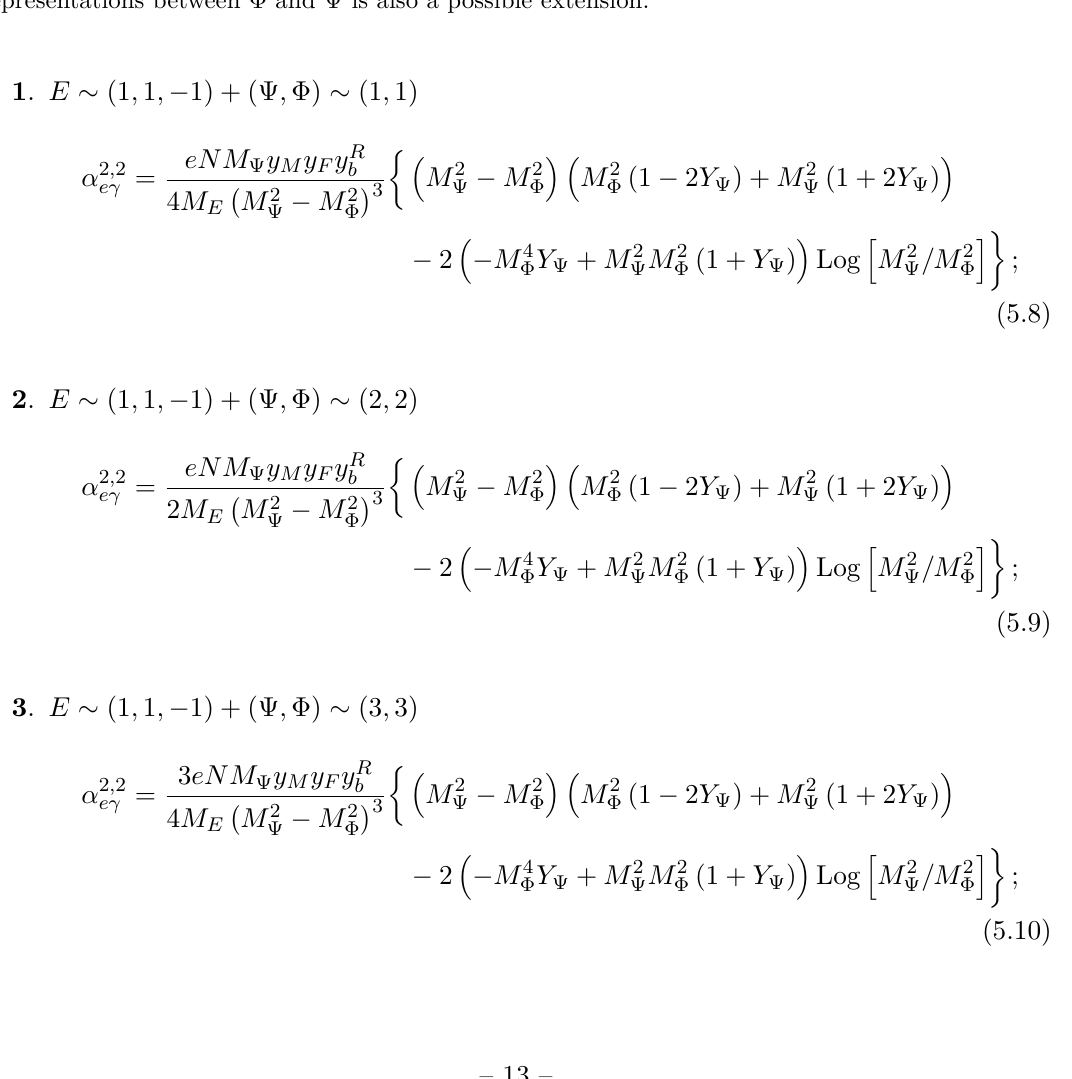
Table 3 . Three-field UV extensions which generate the bridge topology, considering only singlet, doublet and triplet SU(2) representations. We show only the SU(2) representations of the 2 extra fields, Φ and Ψ , since the color representation must be the conjugate of each other and their hypercharge must respect the conditions specified above. Switching the assigned SU(2) representations between Φ and Ψ is also a possible